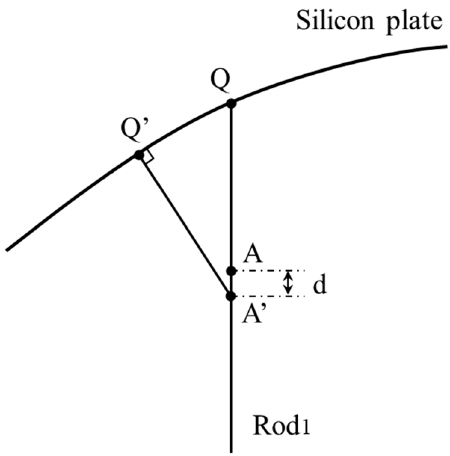
Figure 6. Difference in the heights of the rod set according to the existence of a joint.